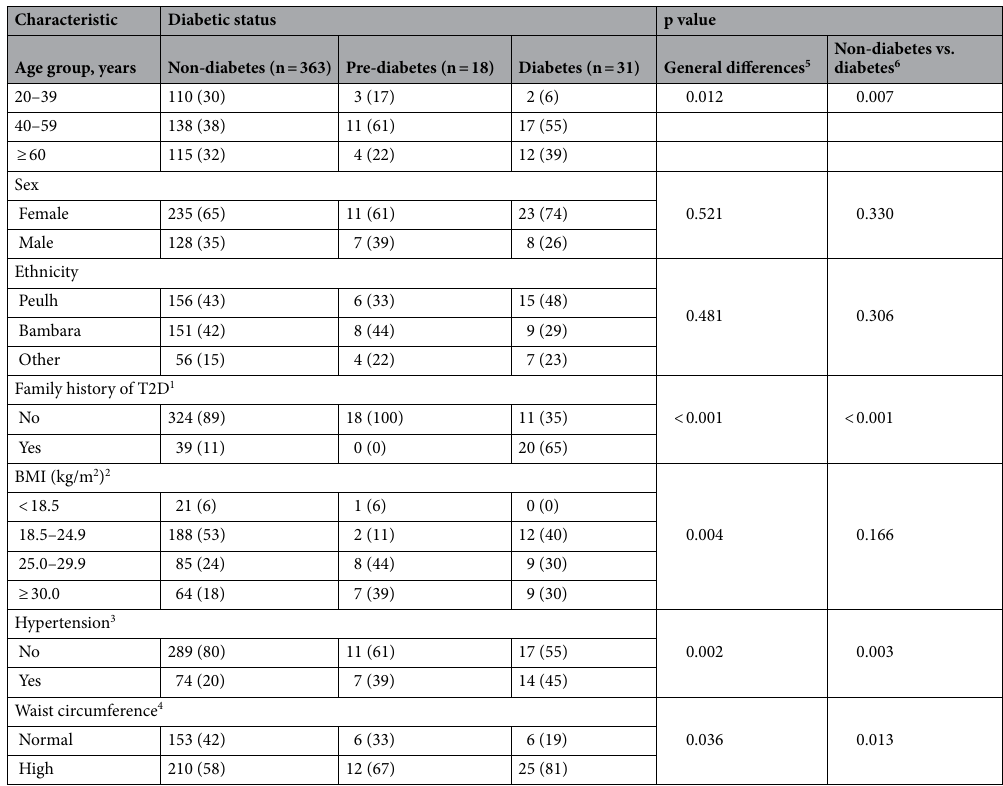
Table 1. Baseline characteristics for n = 412 study participants, Nièna municipality, Mali, 2021. Data are expressed as frequency (column percentage). BMI body mass index, T2D type 2 diabetes. 1 Based on immediate family members (father, mother, sister, or brother). 2 BMI values were missing for five subjects in the non- diabetes group and one subject in the diabetes group. 3 Hypertension defined as prior diagnosis of hypertension or systolic blood pressure greater than or equal to 140 mmHg or diastolic blood pressure of at least 90 mmHg or use of antihypertensive drugs. 4 Normal defined as less than 80 cm and 90 cm for females and males, respectively. High was defined as at least 80 cm and 90 cm for females and males, respectively. 5 Based on Fisher’s Exact Test for general differences among the diabetic groups. 6 Based on Fisher’s Exact Test comparing the non-diabetes and diabetes